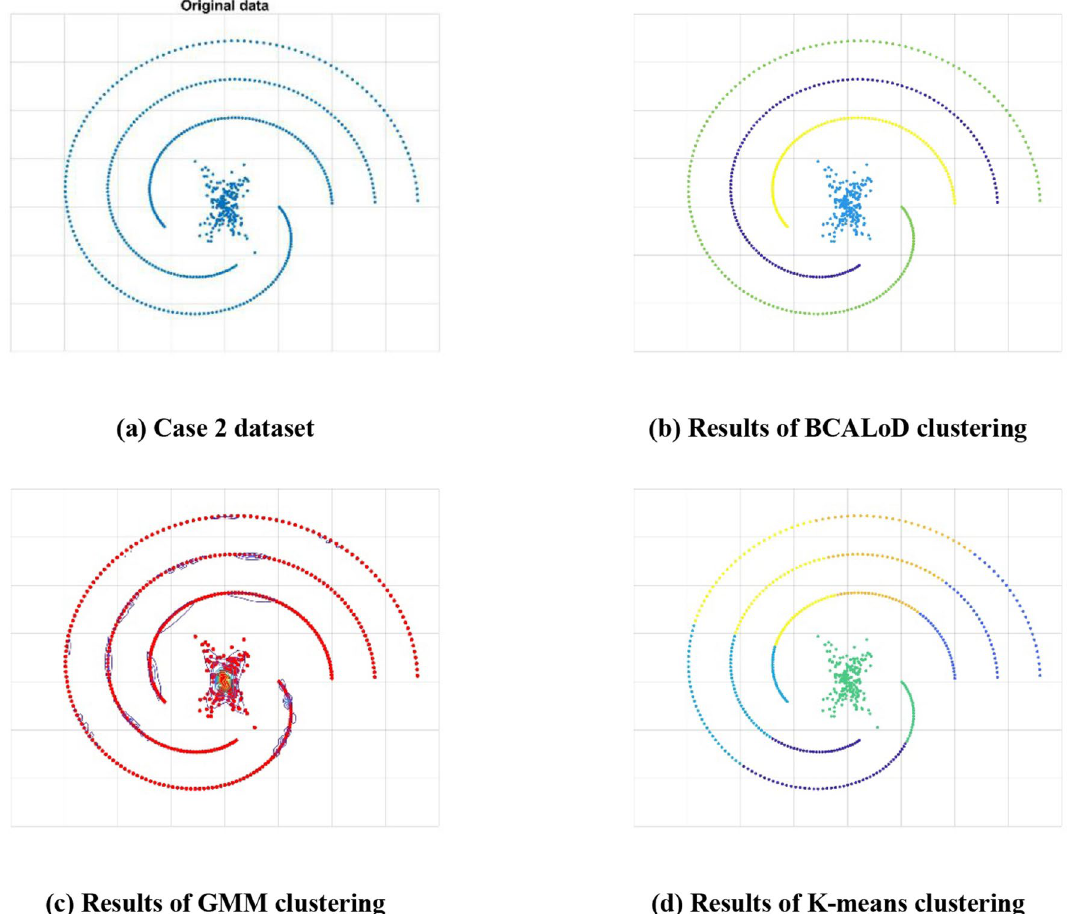
Figure 5. Combination dataset cluster analysis. ( a ) Data points comprised a Gaussian mixture distribution and spirals. ( b ) Accurate numbers of data points in different clusters were obtained by using the BCALoD algorithm. ( c , d ) GMM and K-Mean were used to do cluster analysis for the combination dataset. For non-Gaussian spirals GMM could not calculate the expectation and variance of the dataset. Also, the K-mean method has poor clustering result for spirals data points. In this case, neither the silhouette coefficients nor the BIC could accurately provide the optimal solution of the cluster number, and determining the cluster number was difficult. However BCALoD cluster algorithm could effectively cluster the dataset.